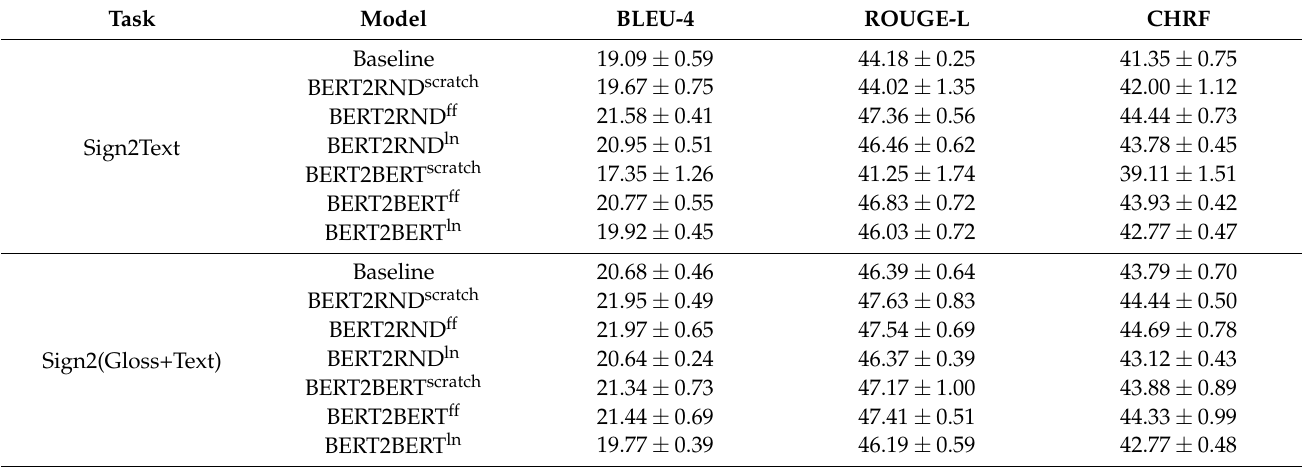
Table 1. Overview of the scores on the development set for the different models, averaged over five trials with different random initialization.